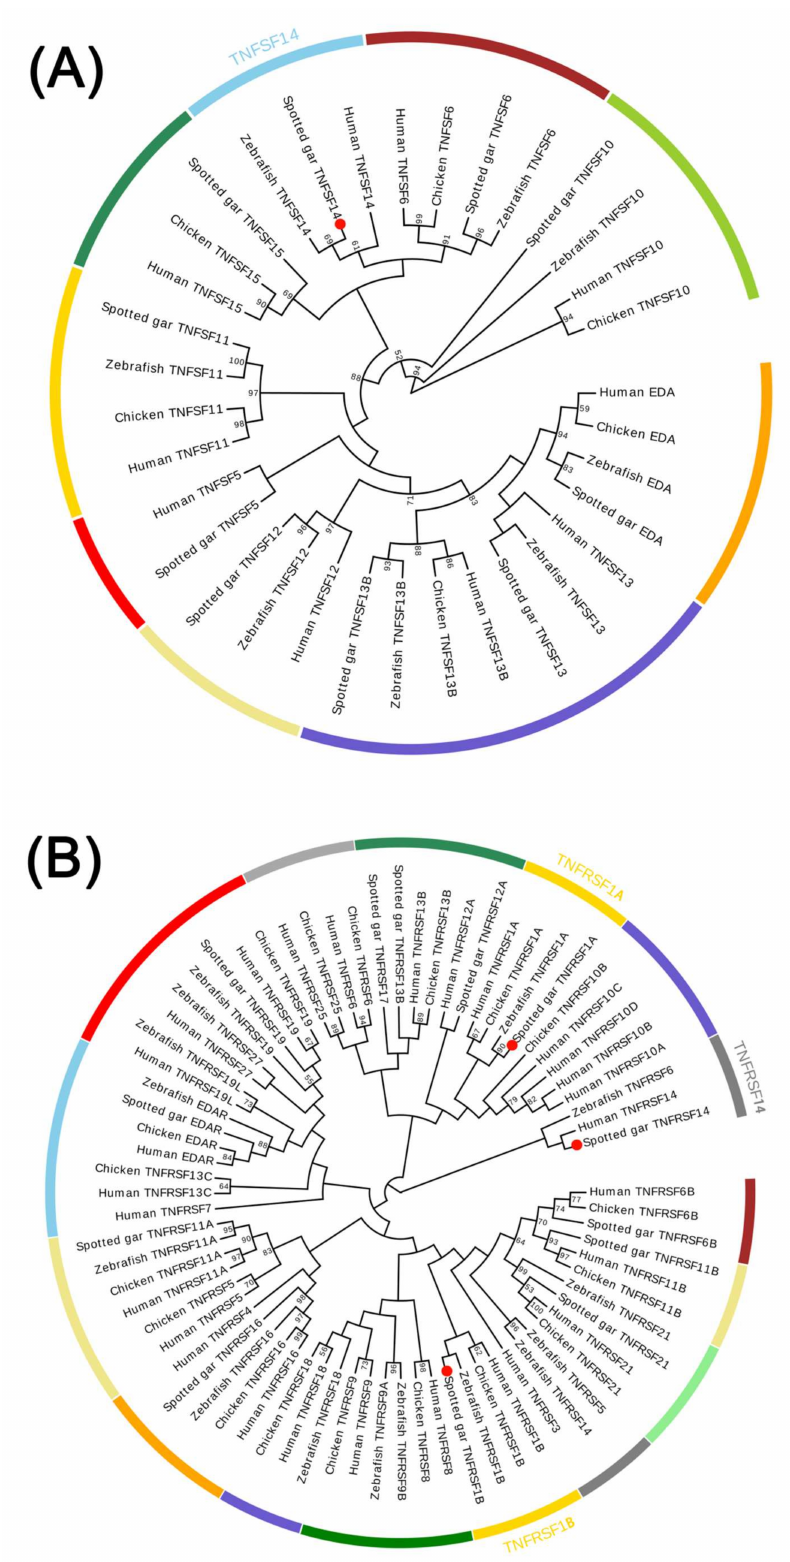
Figure 4. Phylogenetic trees of TNFSF14 ( A ) and TNFRSFs ( B ) proteins. The phylogenetic trees were constructed using the NJ method within the MEGA5.1 program and run for 1000 replications. The percentages of bootstrap values (>50%) for branches are shown. Spotted gar TNFSF14 and TNFRSFs are colored